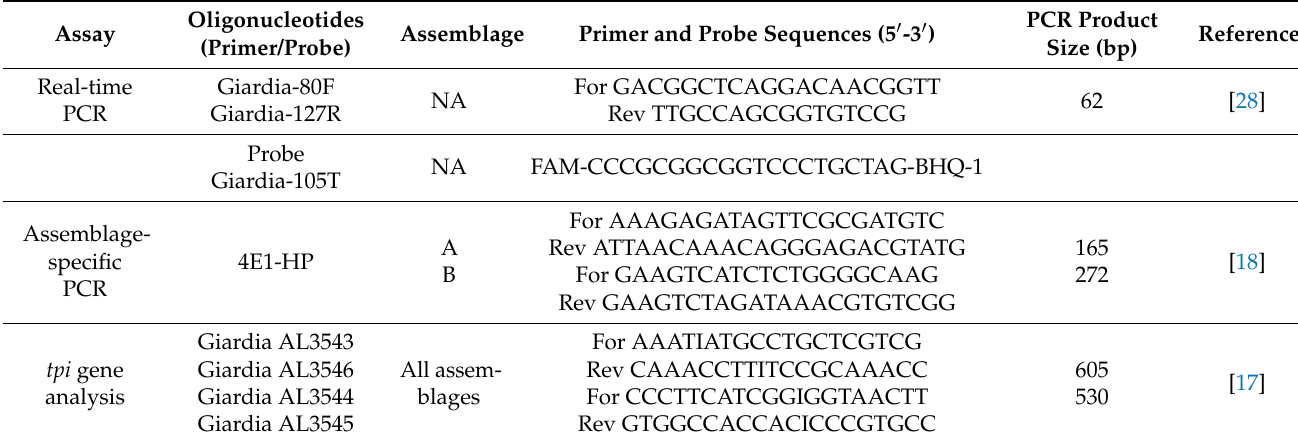
Table 1. List of oligonucleotides used for real-time PCR, assemblage-specific PCR, and tpi gene-based genotyping with indications of the sizes of the